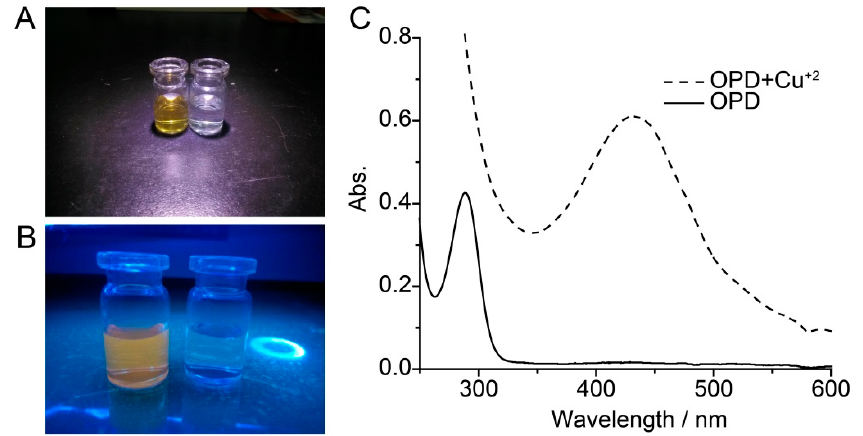
Figure 1. The characterization of the reaction of OPD in the presence of Cu 2+ . ( A ) A photograph showing the OPD solution in the presence (left) and absence of (right) Cu 2+ ; ( B ) Florescent photograph of the above solutions under irradiation by 365 nm ultraviolet light; ( C ) UV-Vis spectra of the solutions.